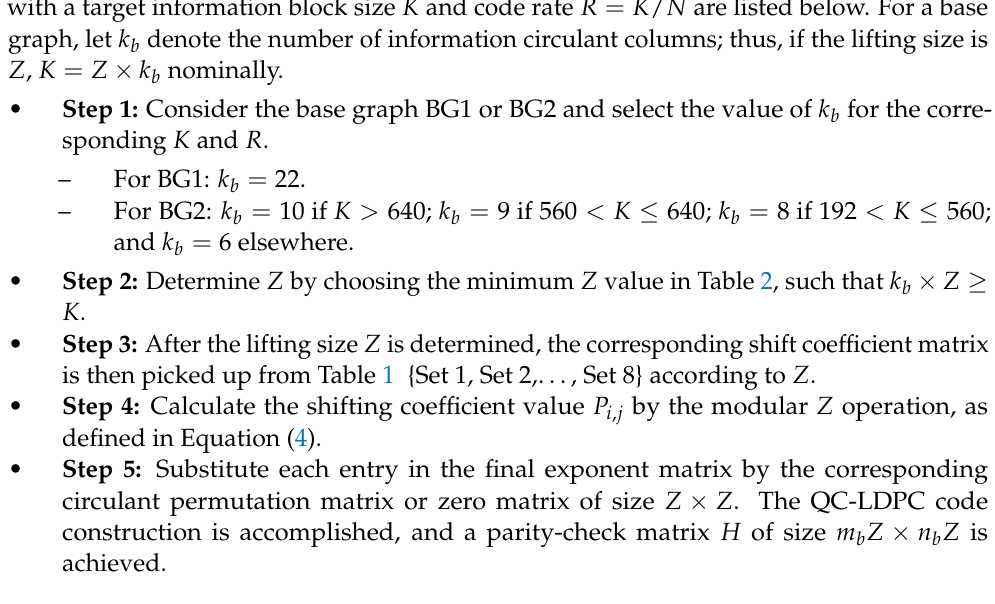
Table 2. Lifting size Z supported by standard 5G QC-LDPC